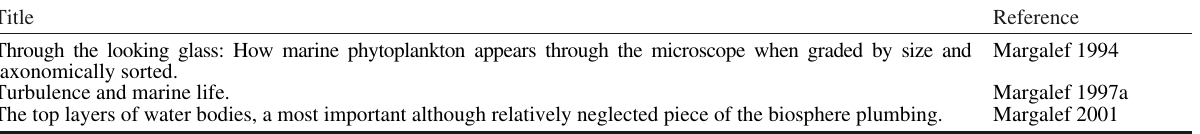
Table 3. – Publications of Ramon Margalef in Scientia Marina (Sci. Mar.).